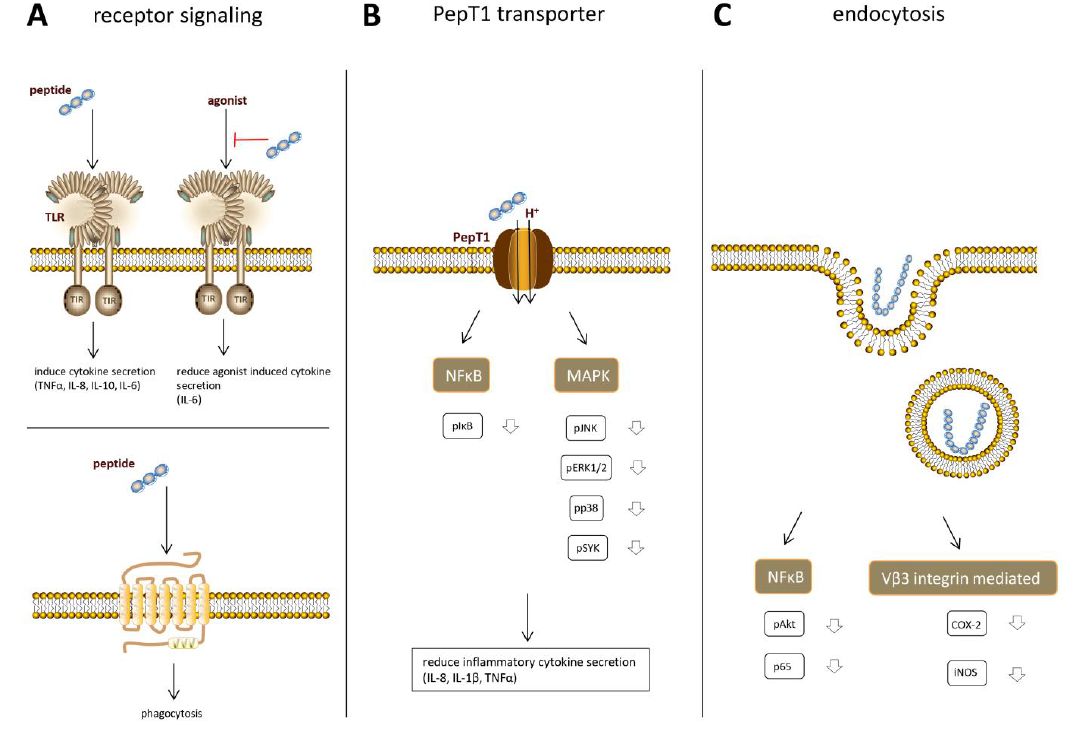
Figure 3. Overview of mechanisms described in the literature via which peptides can exert immunomodulatory effects in the cell. Peptides can ( A ) directly stimulate receptors; ( B ) be taken up in the cell via a peptide transporter and interfere with inflammatory signaling pathways; or ( C ) be taken up into the cell via endocytosis and inhibit inflammatory signaling pathways .